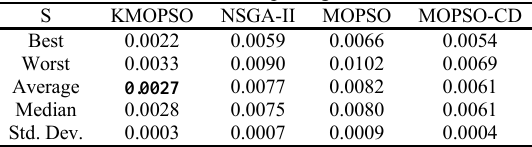
Table 6 . Results of the spacing metric for FON.